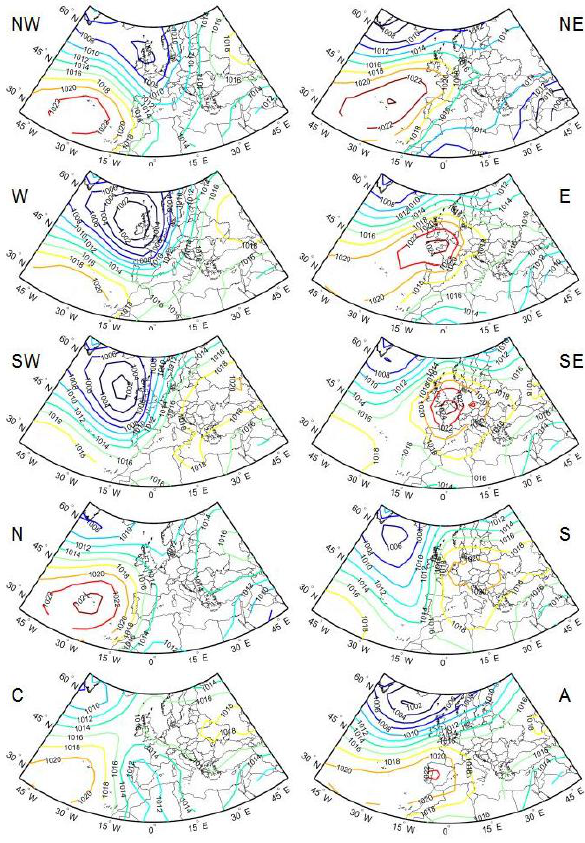
Figure_3 . Composite map of the daily SLP average fields for the eight directional Fig. 3. Composite map of the SLP fields for the eight directional weather types (NW, N, NE, E, SE, S, SW, W) and two vorticity weather types (C and A). Hybrid types are not shown. Contour interval is 2 hPa. weather types (NW, N, NE, E, SE, S, SW, W), and two vorticity weather types (C and A). Hybrid types are not